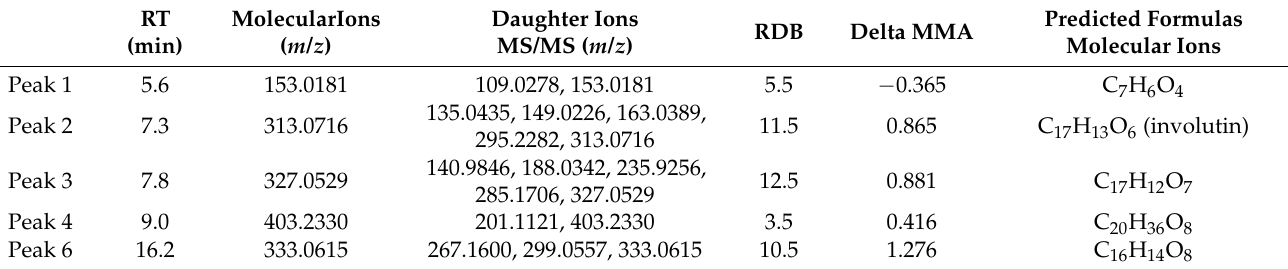
Table 2. High-resolution electrospray ionization-mass spectrometry (HRESIMS) data of the isolated iron(III)-reducing metabolites from P. involutus . Peaks were collected using HPLC and assigned, as shown in Figure 2A. The mass spectra were acquired in negative mode. Elemental composition using the ring double bond (RDB) equivalent and the deviation of the observed mass from the theoretical mass (delta mma) for predicted chemical compositions were considered to predict the chemical formulas 1